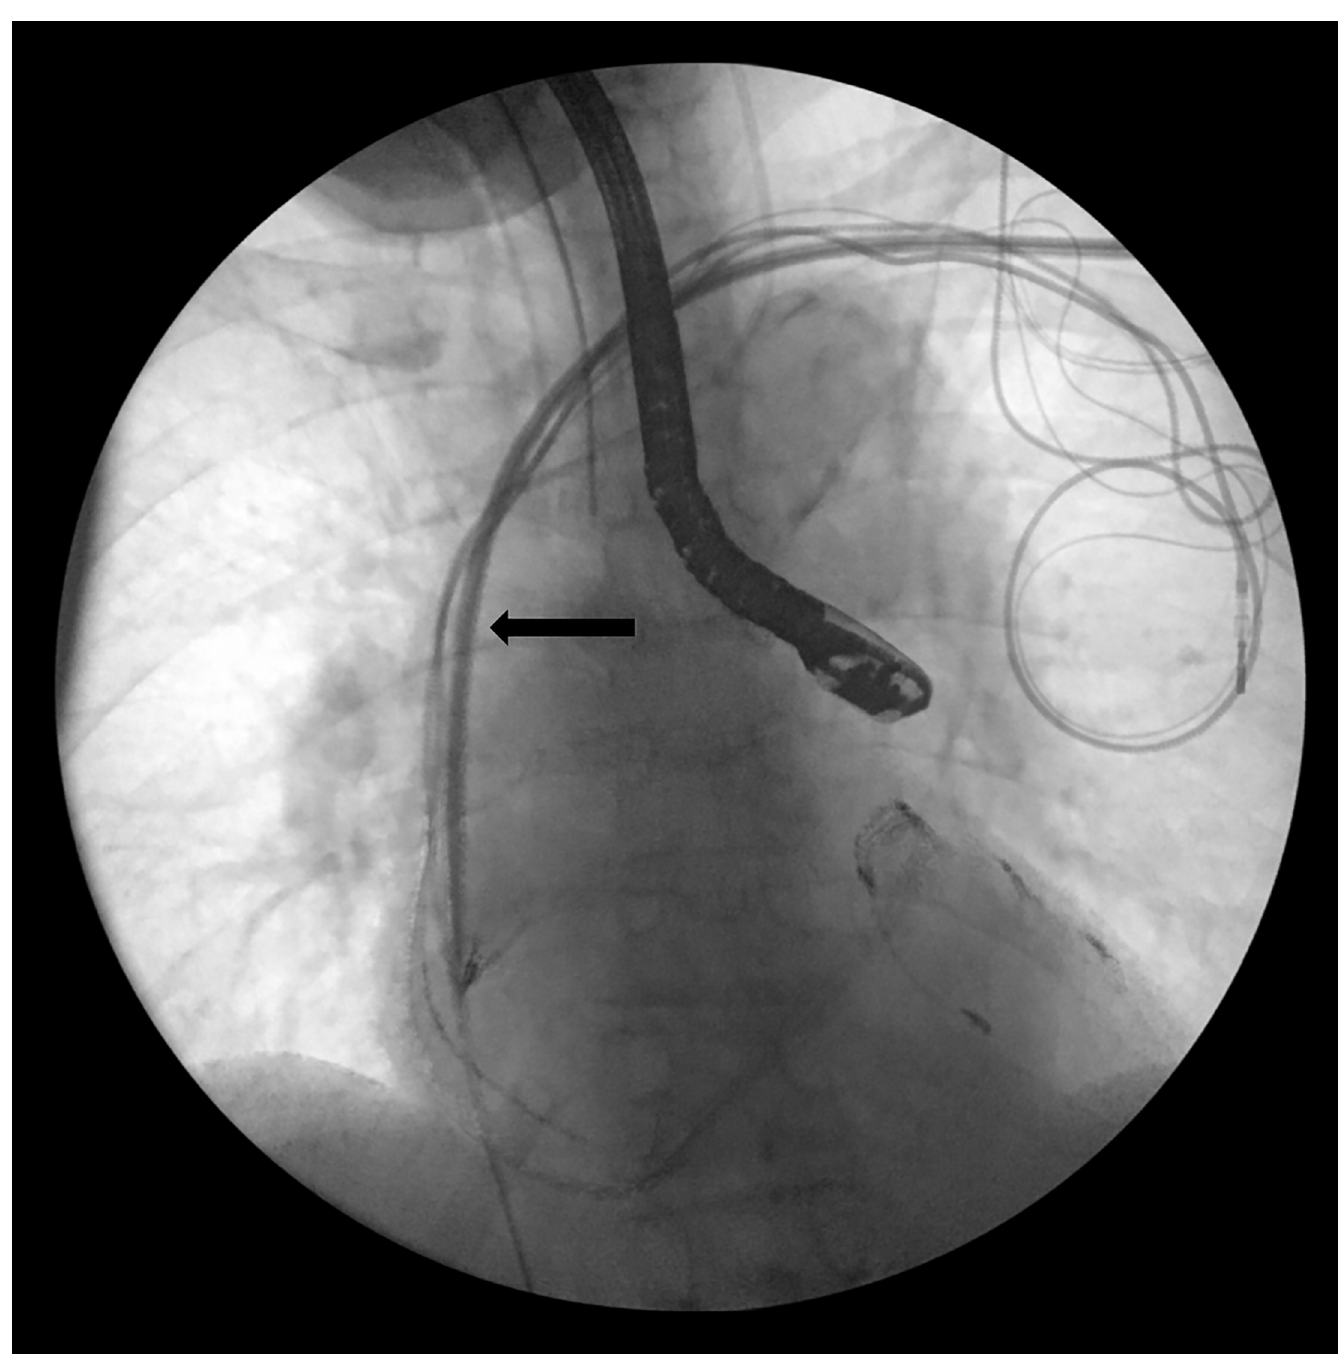
Fig 7. Positioning of the introducer sheath (marked by the arrow) for lead implantation over the guide wire.